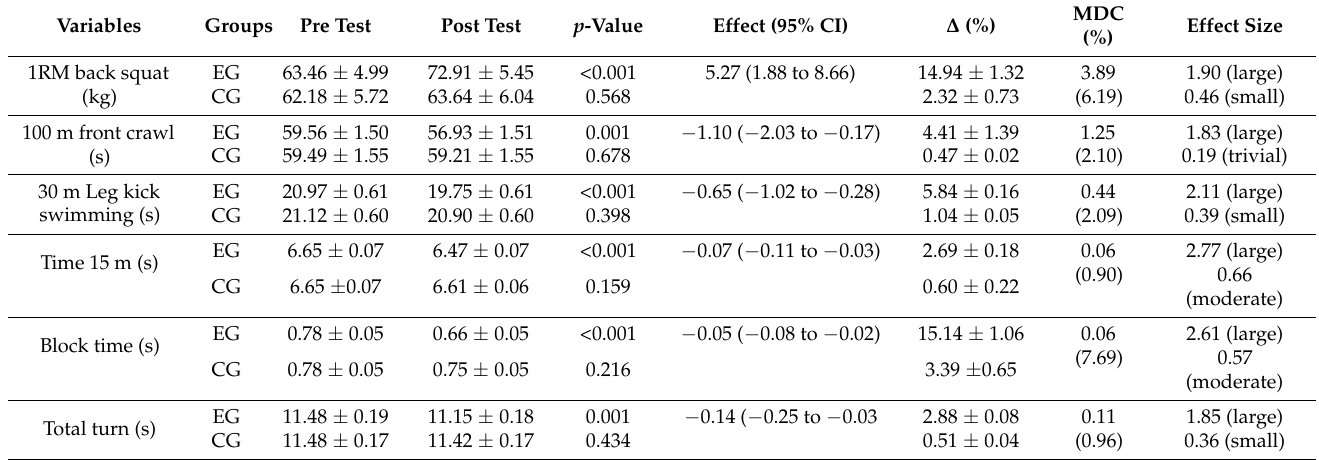
Table 2. Changes in the maximum lower body strength, swimming, start and turn performances between the pre and post test in the experimental (EG) and control